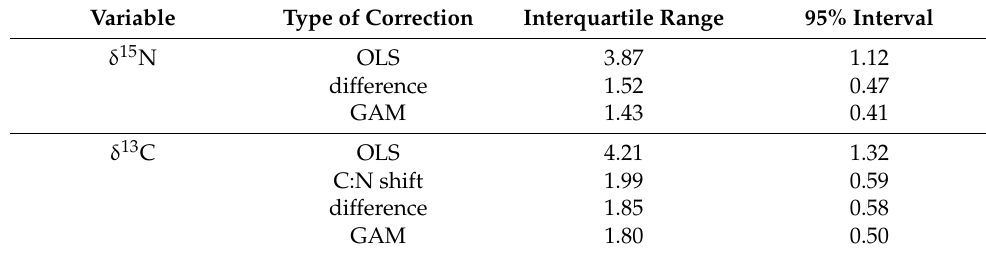
Table 3 . Values (‰) of the interquartile range (25–75% quartiles) and the 95% con fi dence interval of the mean o ff set between estimated and observed values in dry zooplankton samples using di ff erent types of correction models. OLS: ordinary least squares regression; di ff erence: mean di ff erence between formalin and dry sample values; GAM: generalised additive models; C:N shift: regression between di ff erence values and the relative change in C:N caused by formalin .